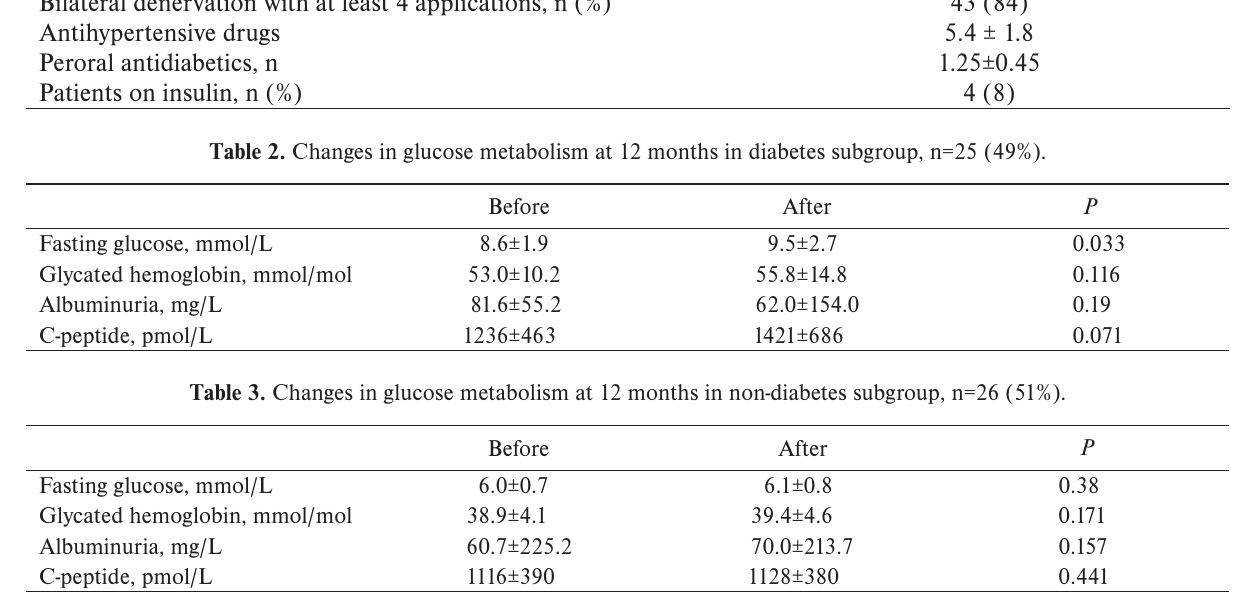
Table 4. Changes in glucose metabolism at 12 months in bilateral denervation and at least 4 applications to each renal artery subgroup, n=43 (84%).